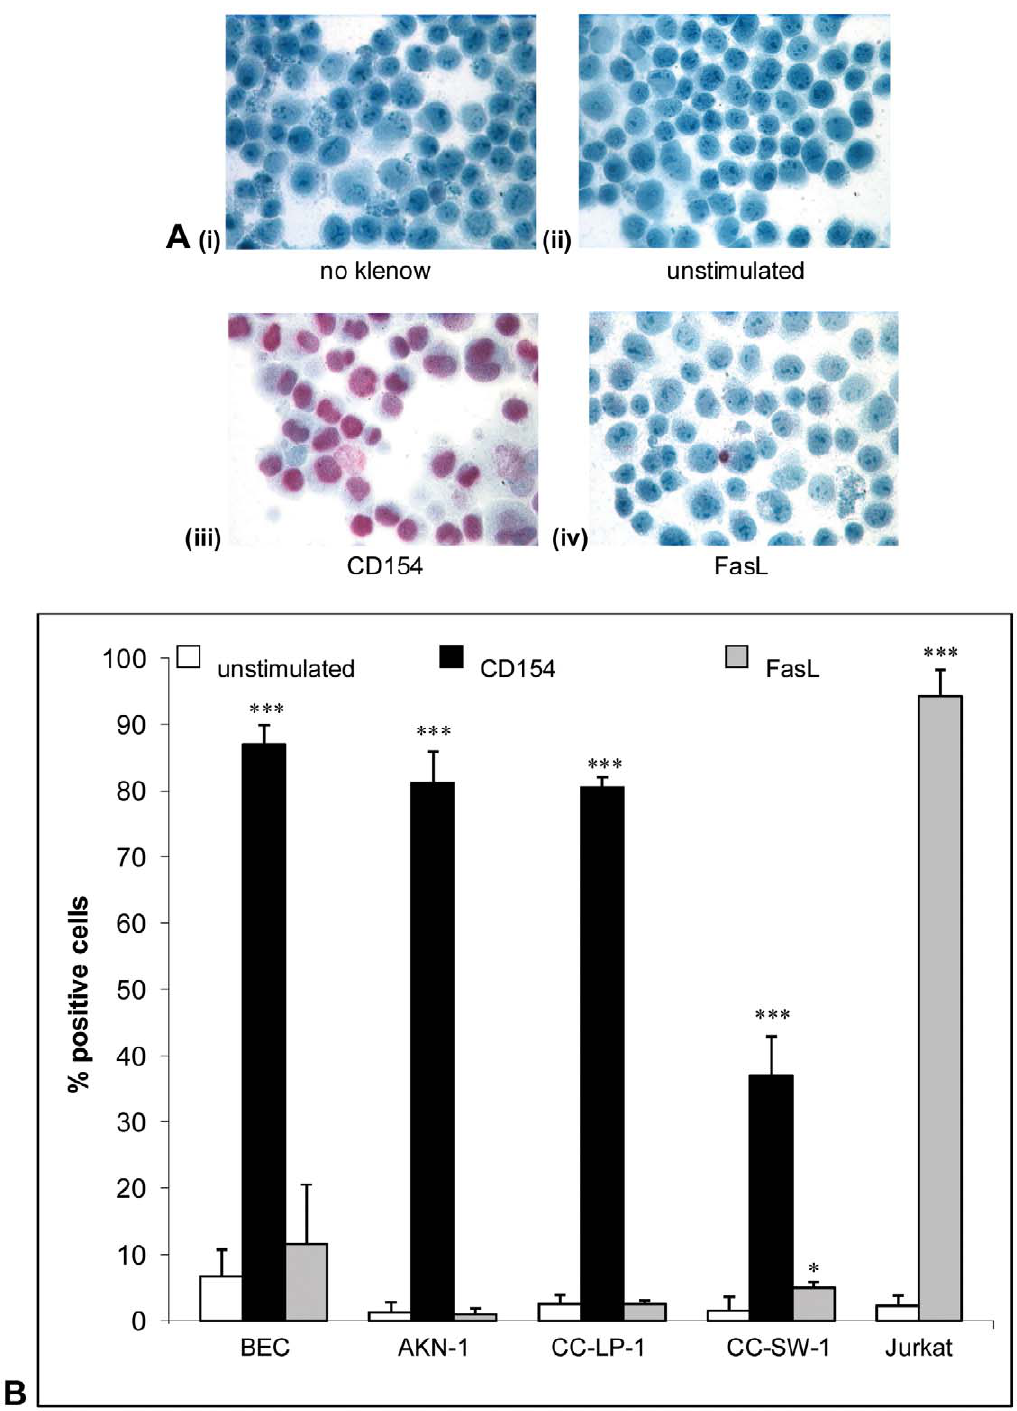
Figure 4. Apoptosis induction in cholangiocytes after stimulation with soluble TNF ligands. All cells were cytocentrifuged and stained by the standard ISEL technique to detect apoptosis after culture in media alone, media with srh CD154 at 1 m g/ml or media with srh FasL at 50 ng/ml for 24 hours. All control slides without DNA polymerase klenow fragment were negative (a i). (a ii) primary cholangiocytes in media alone, (a iii) shows primary cholangiocytes stimulated with soluble CD154 and (a iv) primary cholangiocytes challenged with soluble FasL. (b) shows the percentage positive ISEL stained cells in all cell types when grown in media alone, with CD154 or with FasL. n=3 + / 2 standard deviation. *p , 0.05, **p0.01, ***p , 0.001 as compared to untreated controls.